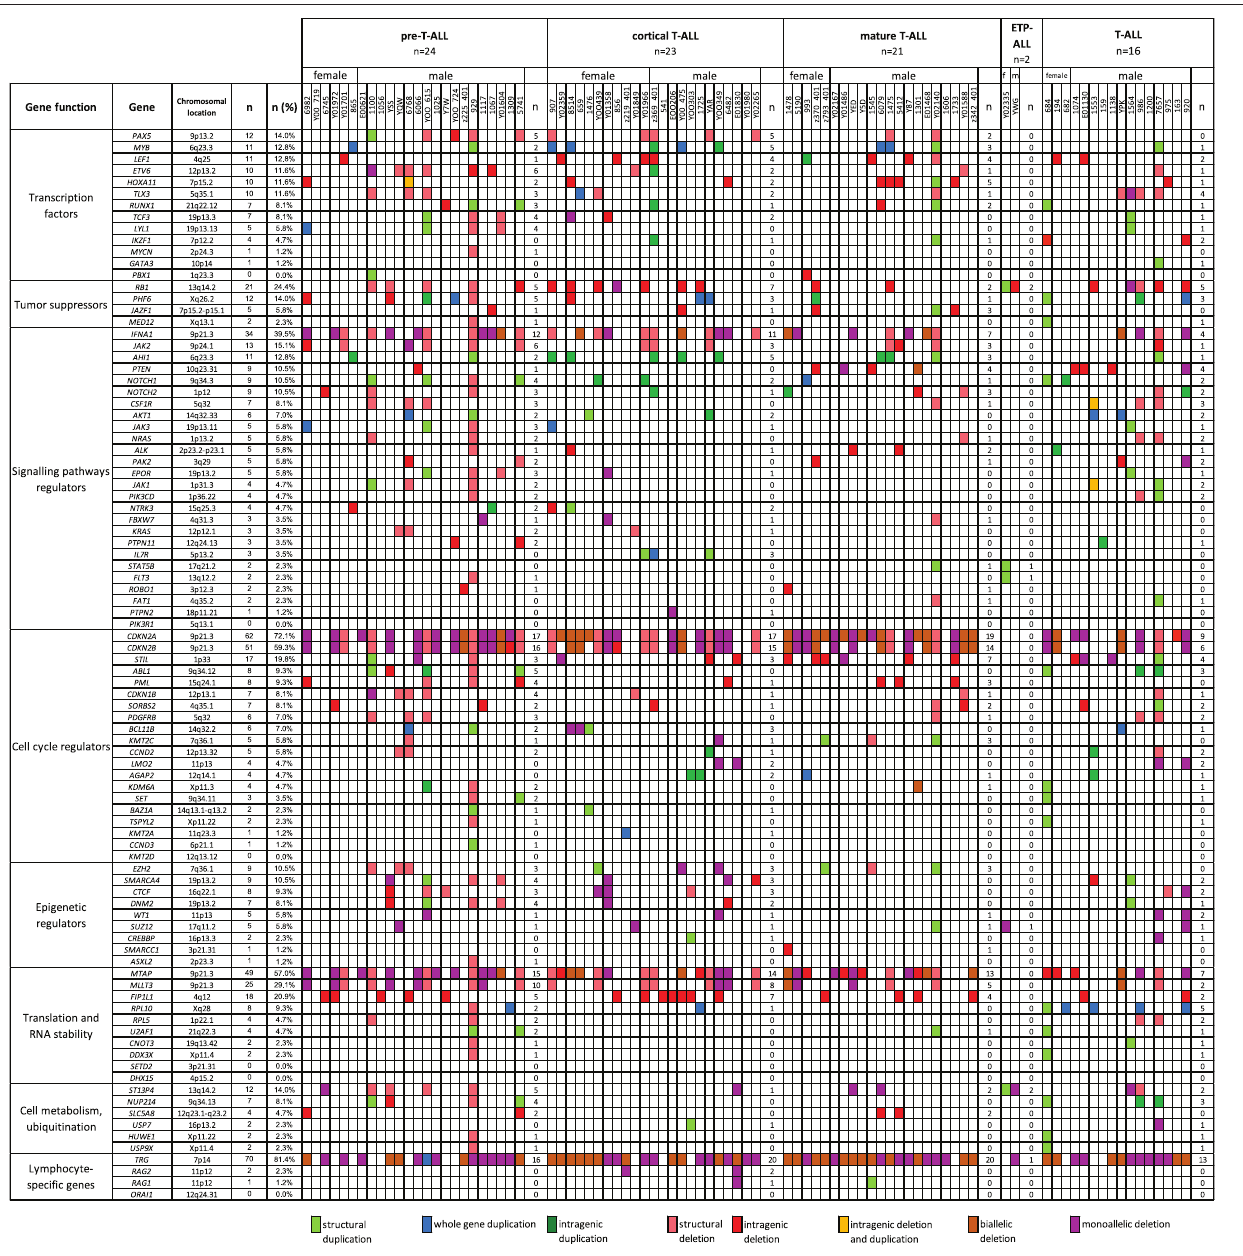
FIGURE 6 | The frequencies of CNAs of all 92 selected genes in 86 T-ALL cases according to particular T-ALL subtypes. Owing to the small amount of data on the CNA frequency observed in T-ALL (data reported thus far are focused on the mutation status of analyzed genes), it is unclear what effects individual changes have on the pathogenesis and course of